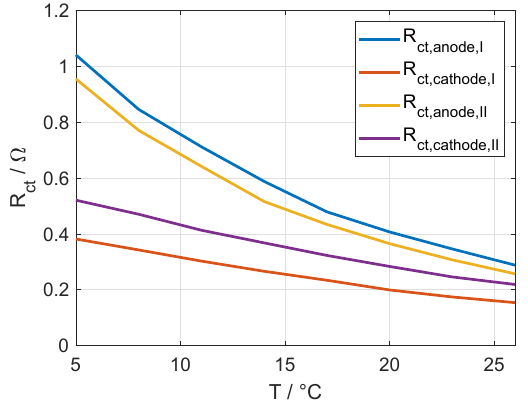
Figure 6. Charge transfer resistances of all electrodes determined with half-cell measurements of cell I and II at various